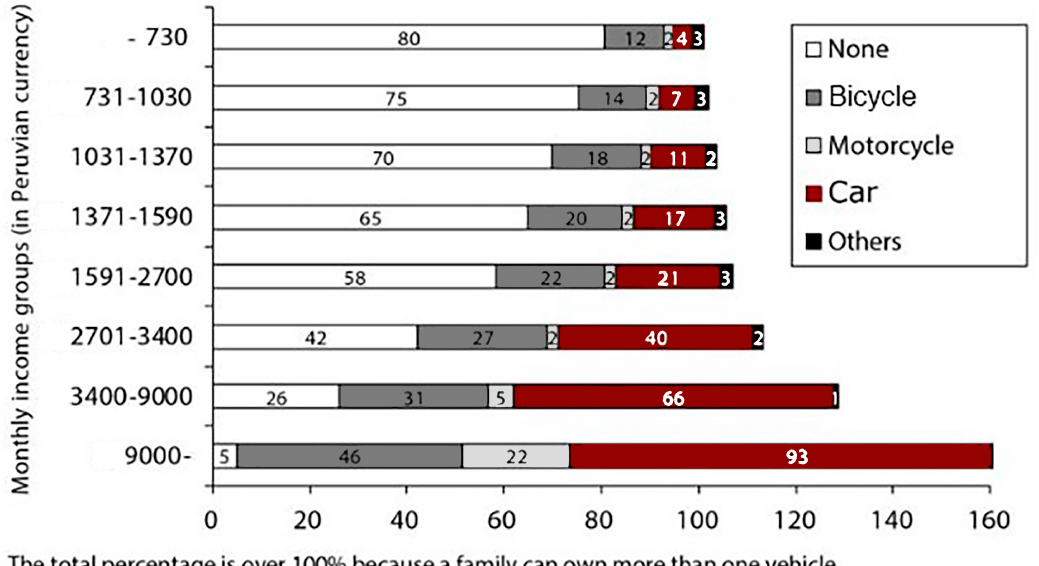
Figure 13. Vehicle ownership according to monthly income. Source: Reference [39]. Graph edited and translated by author.